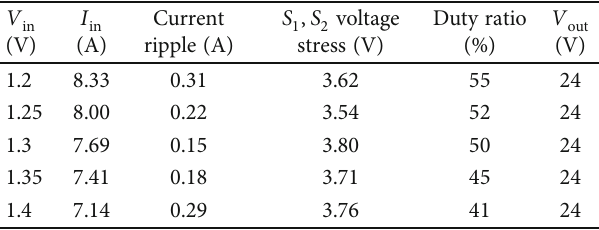
Figure 15: Input current ripple waveform.